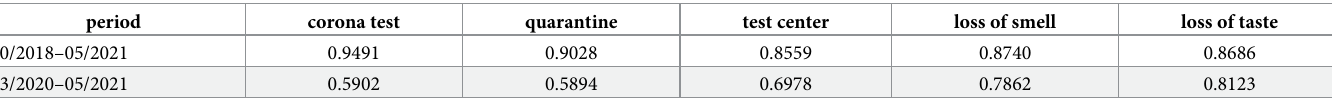
Note: Table depicts the Spearman rank-order correlation coefficients. All values are significant at the 5%